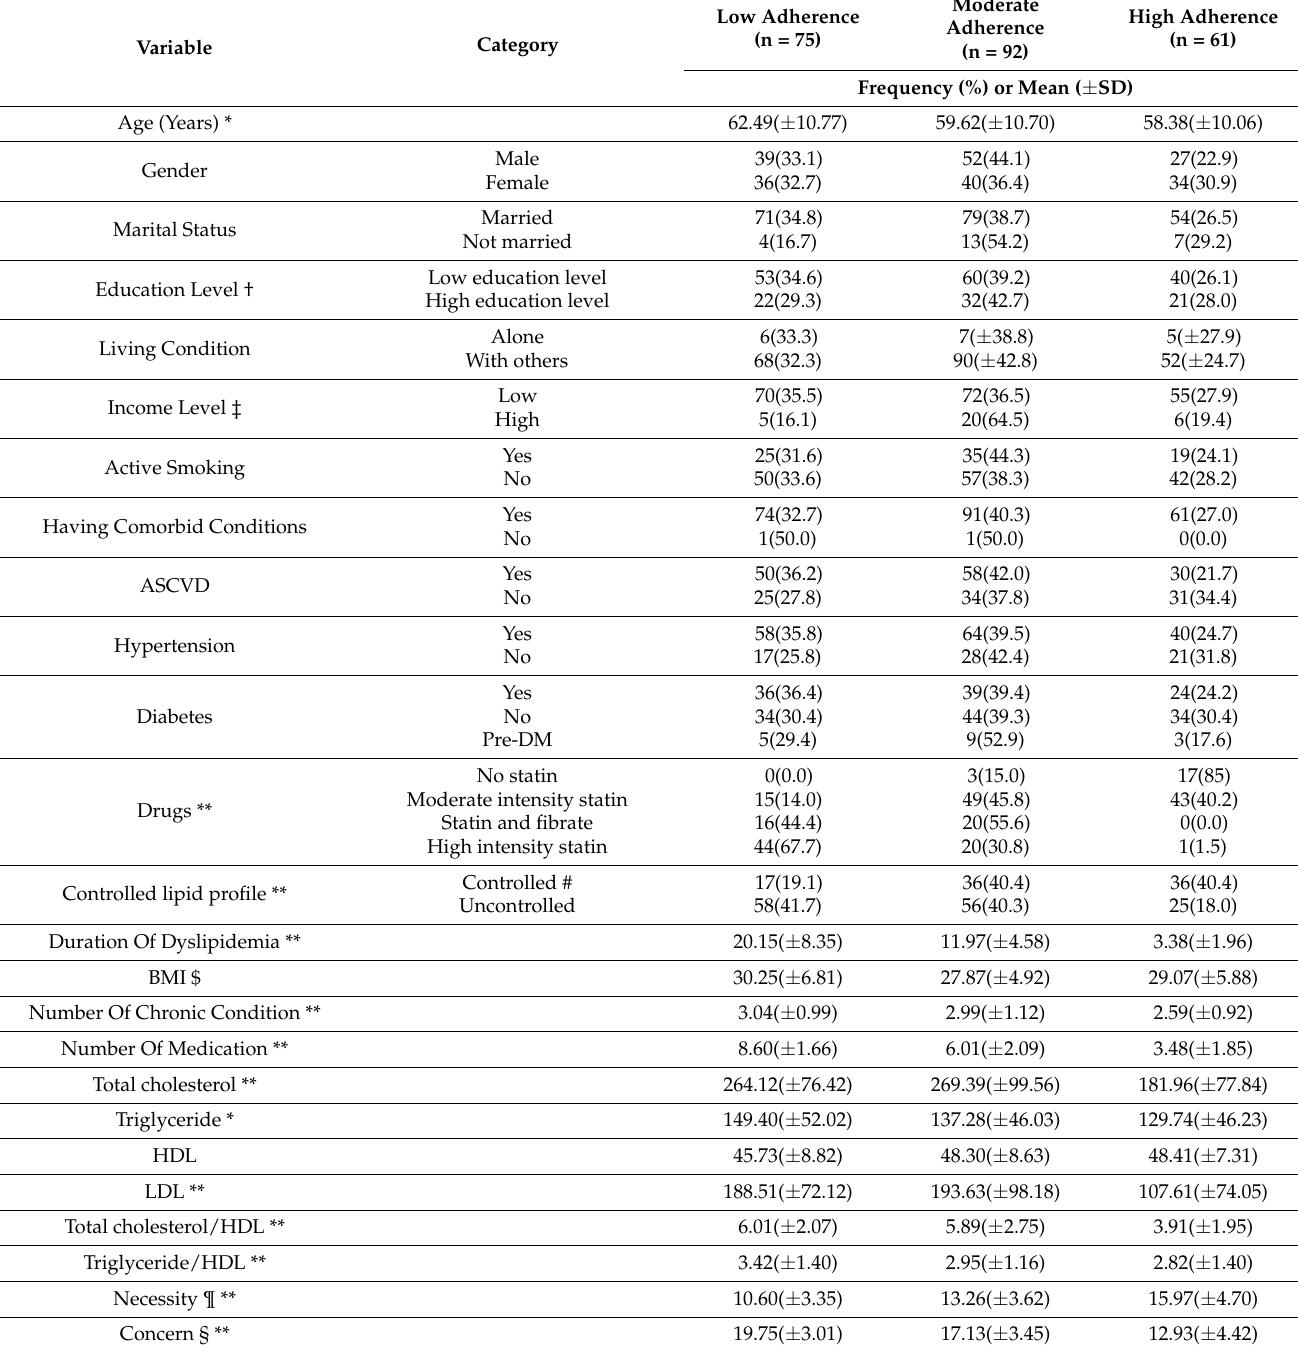
Table 1. Association between adherence level and different sample